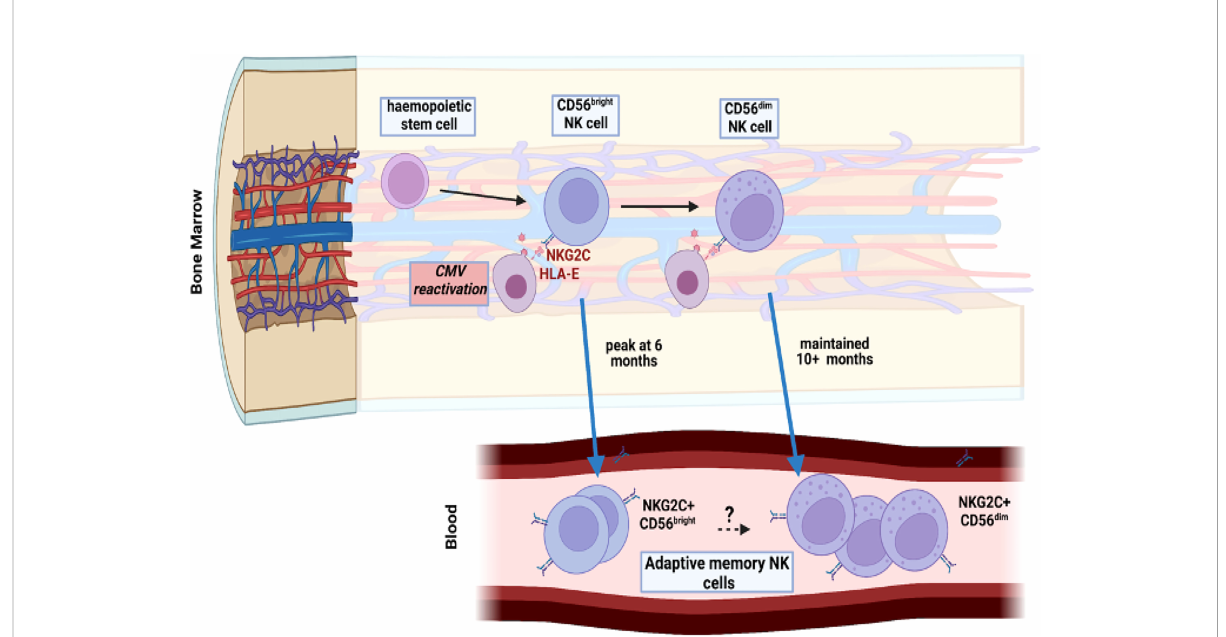
FIGURE 6 Model of potential maintenance of the adaptive memory NK cell pool through reactivation of CMV within bone marrow. CMV reactivation leads to a pattern of increased peripheral expression of NKG2C on both CD56 dim mature NK cells and the more immature CD56 bright subset. The peak of this expansion occurs earlier, at 6 months, in the immature population compared to 10 months in the mature subset. Viral reactivation may potentially engage both populations independently or CD56 dim cells may differentiate from the more immature CD56 bright